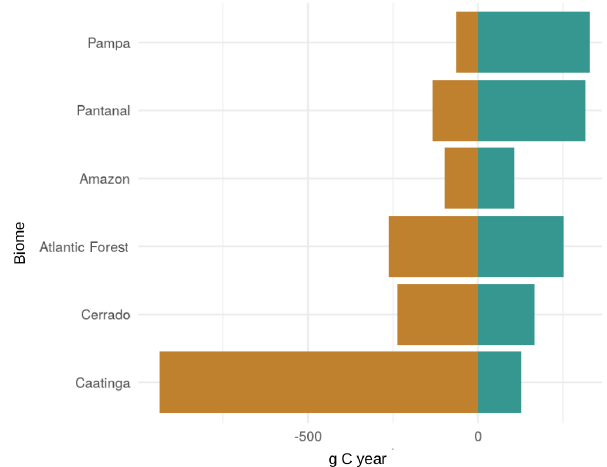
Figure 8. Primary productivity trends across Brazilian biomes based on the GOSIF GPP product across the analyzed period of time